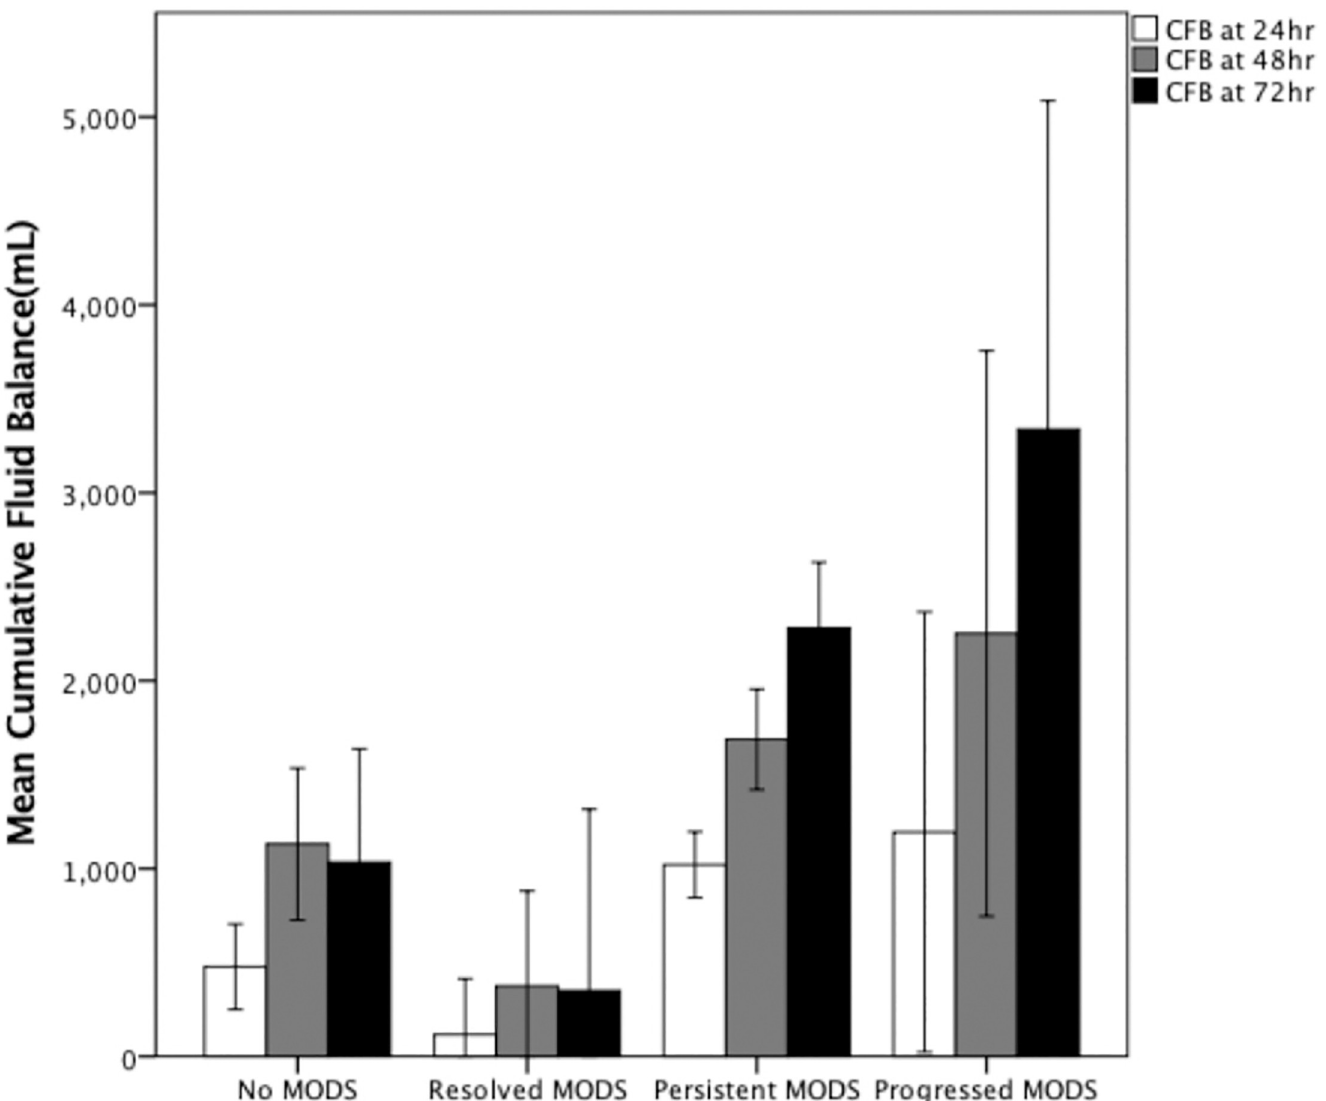
Fig 4. 72-hr cumulative fluid balance (CFB) in patients with resolved persistent multiple organ dysfunction syndrome (MODS), progressive MODS, or without MODS from 24 hr to 72 hr after onset of septic shock. Open bars indicate 24-hr CFB; gray bar indicates 48-hr CFB; black bars indicate 72-hr CFB (data expressed as mean ±